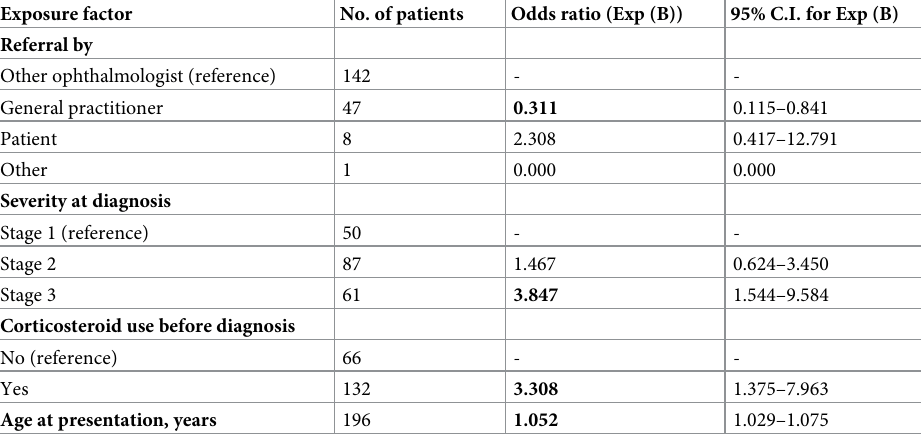
Table 4. Multivariable logistic regression analysis on ‘treatment